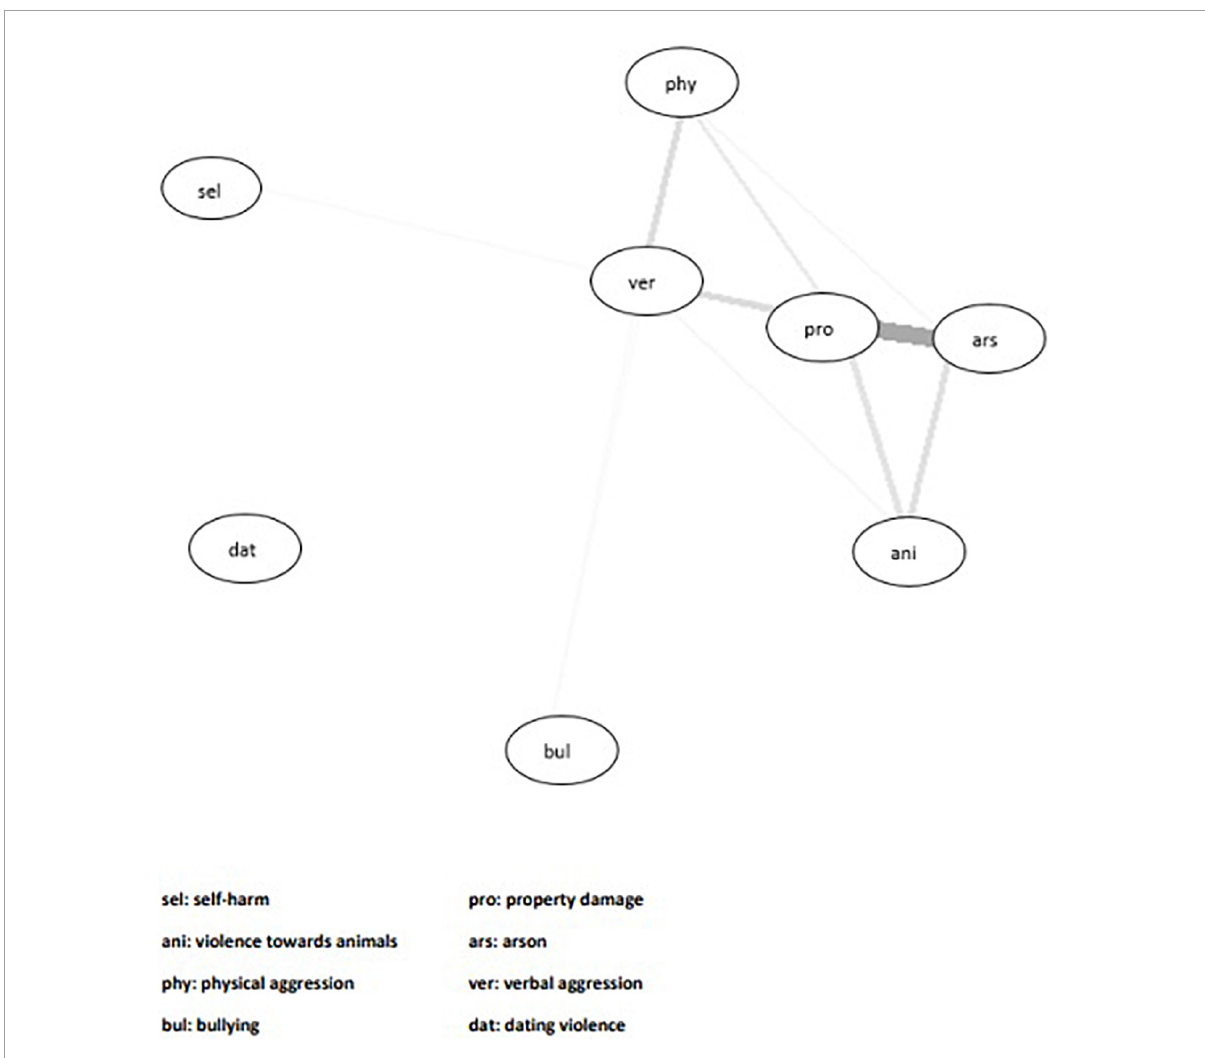
FIGURE1 Network model showing the interconnections between all harmful behaviour variables in the entire sample. A connection between two variables is demonstrated by an edge between nodes.